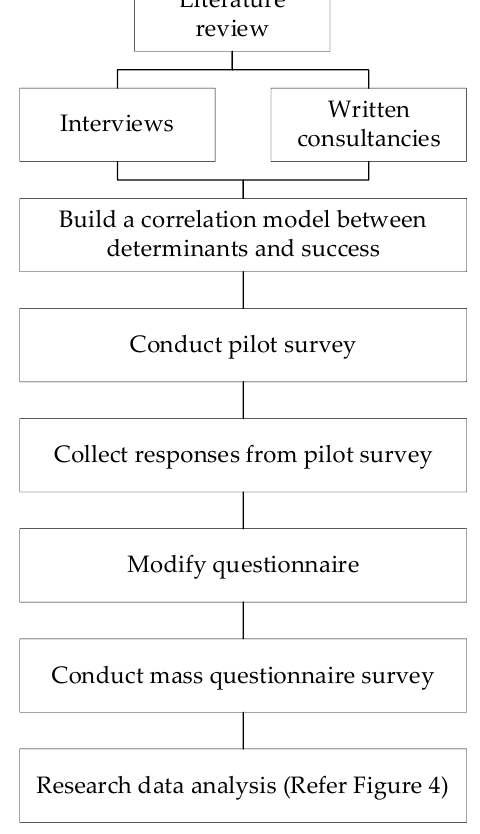
Figure 2. Methodology for data collection.